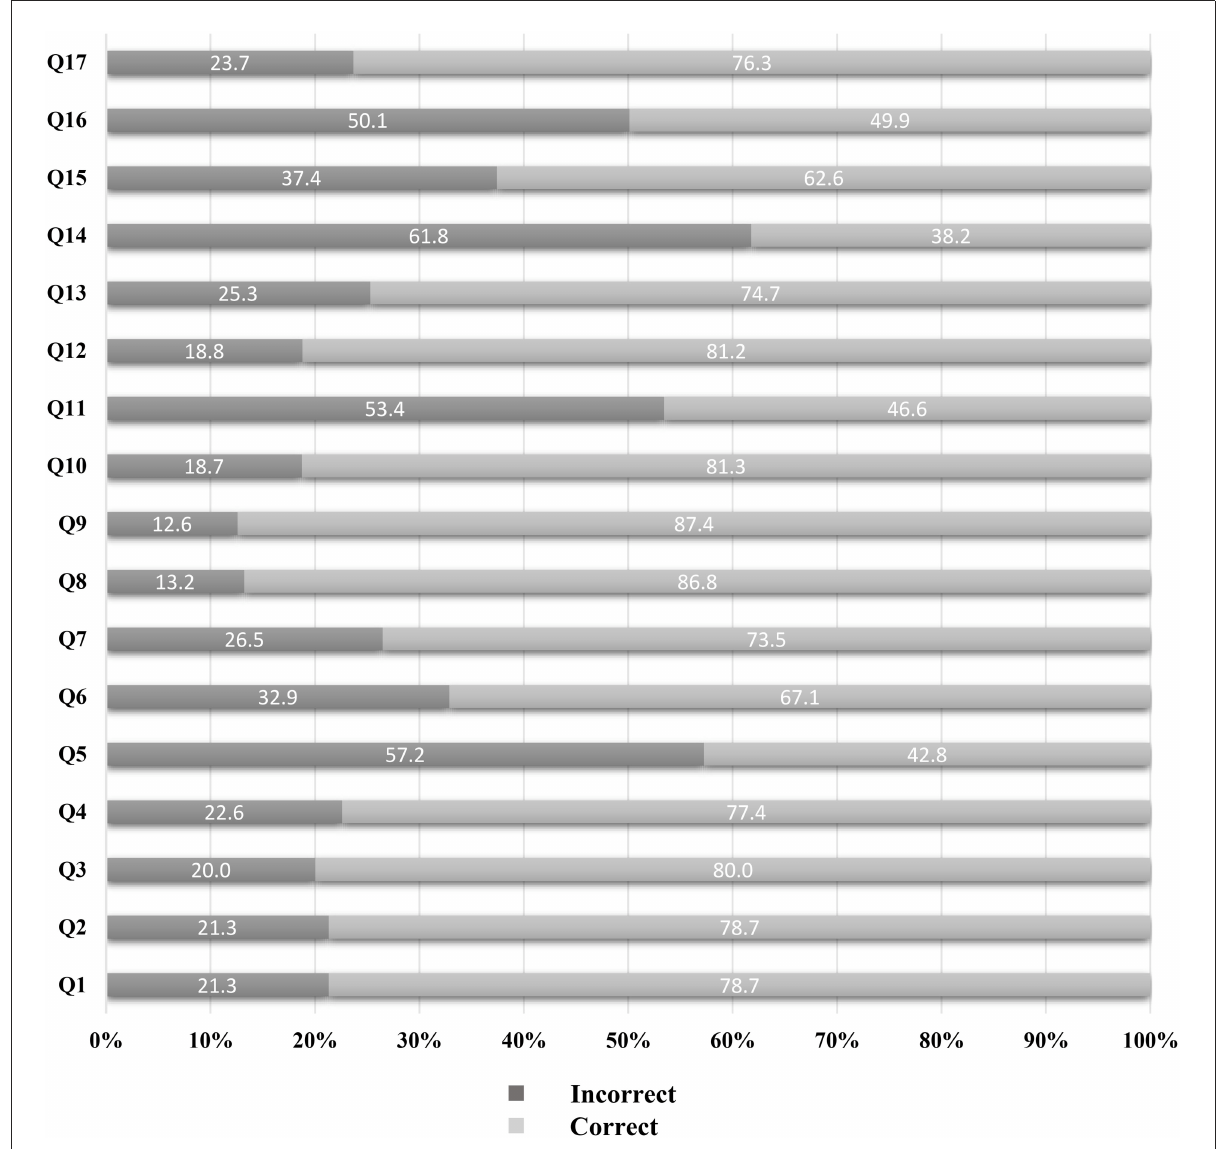
FIGURE3 Proportion of answering on seventeen dietary knowledge questions among participant with high-normal blood pressure. Q1: Choosing a diet with a lot of fresh fruits and vegetables is good for one’s health; Q2: Eating a lot of sugar is good for one’s health; Q3: Eating a variety of foods is good for one’s health; Q4: Choosing a diet high in fat is good for one’s health; Q5: Choosing a diet with a lot of staple foods (rice and rice products and wheat and wheat products) is not good for one’s health; Q6: Consuming a lot of animal products daily (fish, poultry, eggs, and lean meat) is good for one’s health; Q7: Reducing the amount of fatty meat and animal fat in the diet is good for one’s health; Q8: Consuming milk and dairy products is good for one’s health; Q9: Consuming beans and bean products is good for one’s health; Q10: Physical activities are good for one’s health; Q11: Sweaty sports or other intense physical activities are not good for one’s health; Q12: The heavier one’s body is, the healthier he or she is; Q13: Eating salty foods can cause hypertension; Q14: Refined grains (rice and wheat flour) contain more vitamins and minerals than unrefined grains; Q15: Lard is healthier than vegetable oils; Q16: Vegetables contain more starch than staple foods (rice or wheat flour); Q17: Eggs and milk are the important sources of high-quality protein.